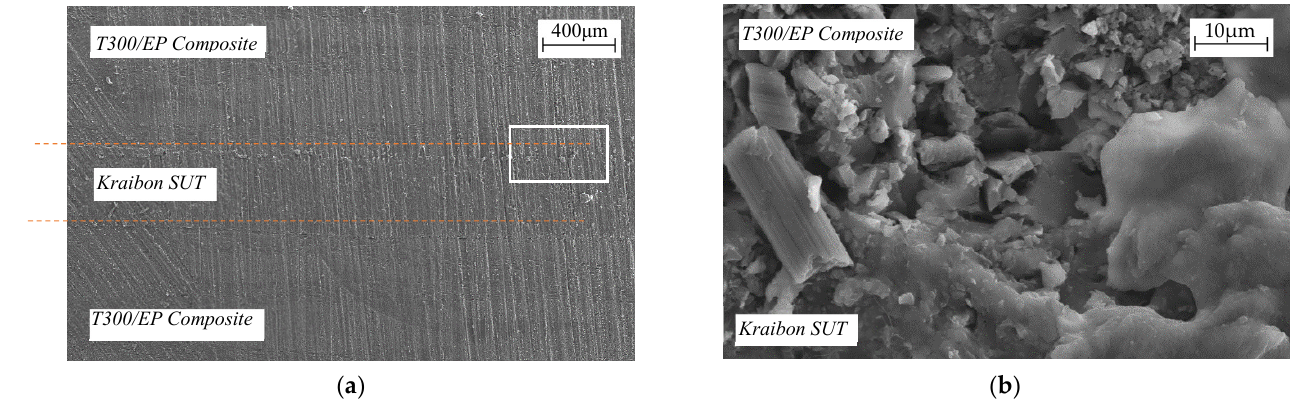
Figure 7. SEM images of a sandwich damped with Kraibon SUT: magnitude ( a ) 110× and ( b ) 5000×.